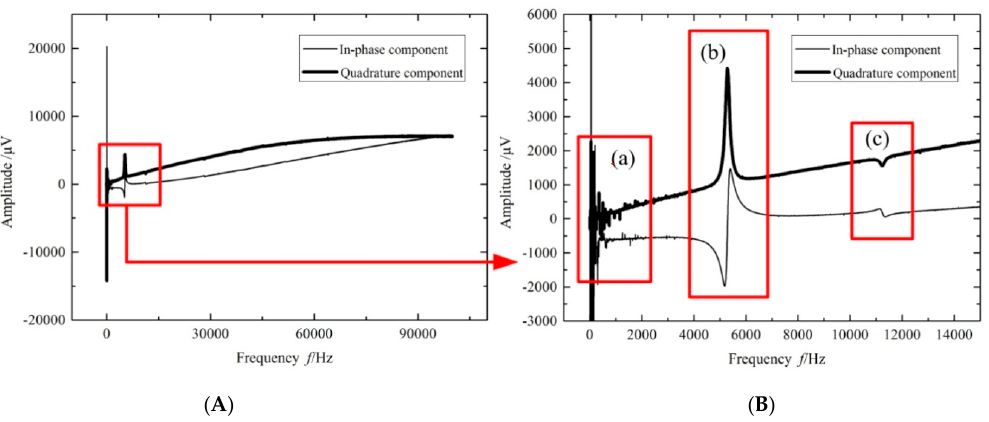
Figure 10. Sweep frequency results of rectangular micro-cantilever in 0.65 cs silicone oil. ( A ) The curve of sweep frequency; ( B ) The detail of red box in picture ( A ): The red box (a) is the noise below 2 kHz; (b) is the first order resonance (fFlexure); (c) is the second order resonance (tTorsion). Table 1. Experimental results of rectangular micro-cantilever chip under flexural resonant mode.